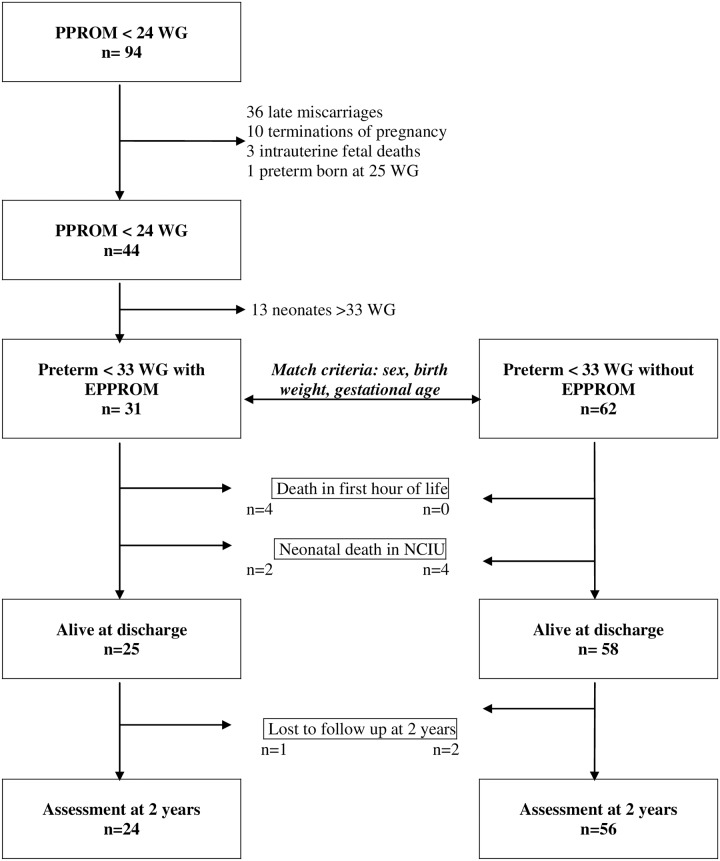
Outcomes of 94 cases of PPROM before 24 WG.WG: Weeks of Gestation; EPPROM: Early Preterm Premature Rupture Of Membranes; NCIU: Neonatal Intensive Care Unit.